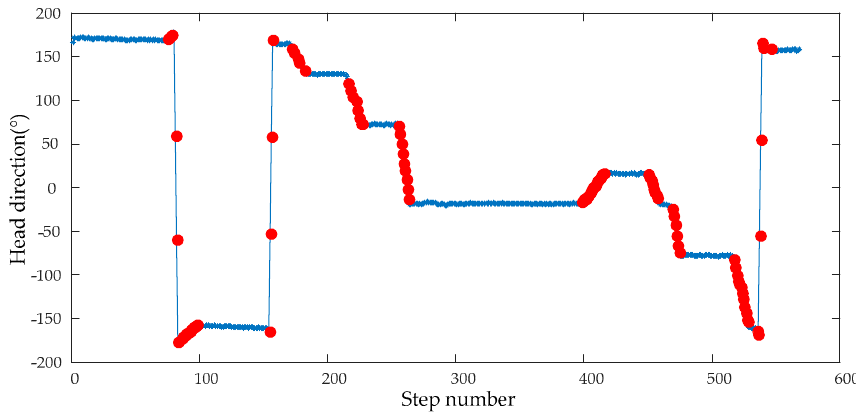
Figure 18. The result of the straight walking detection.